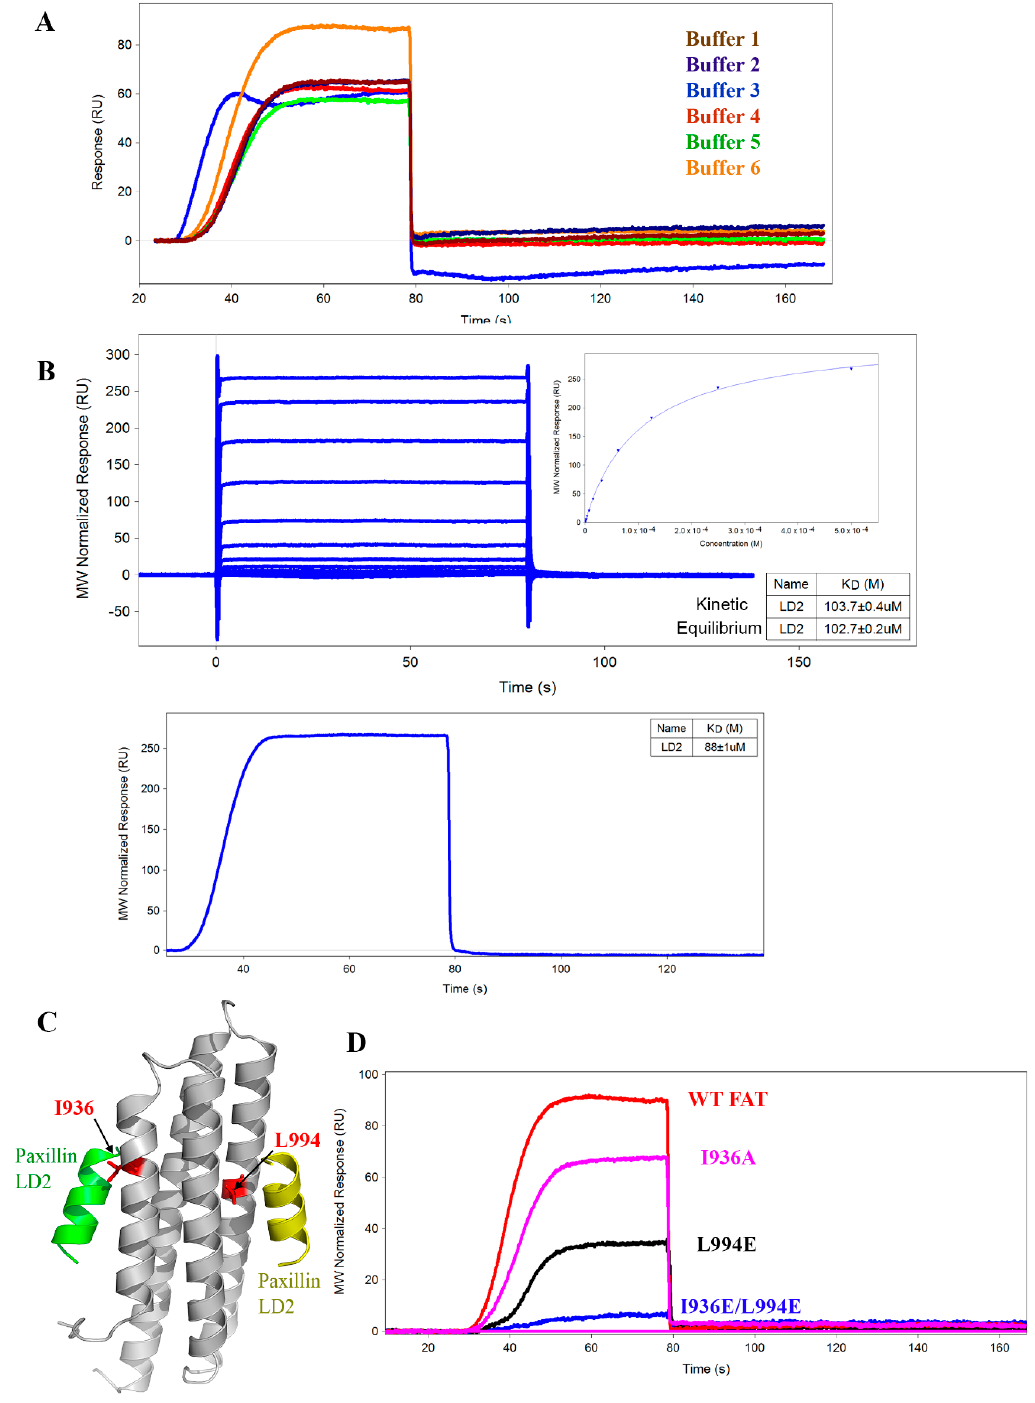
Figure 2 . Development and optimization of SPR assay. ( A ) SPR sensorgram of AviTag